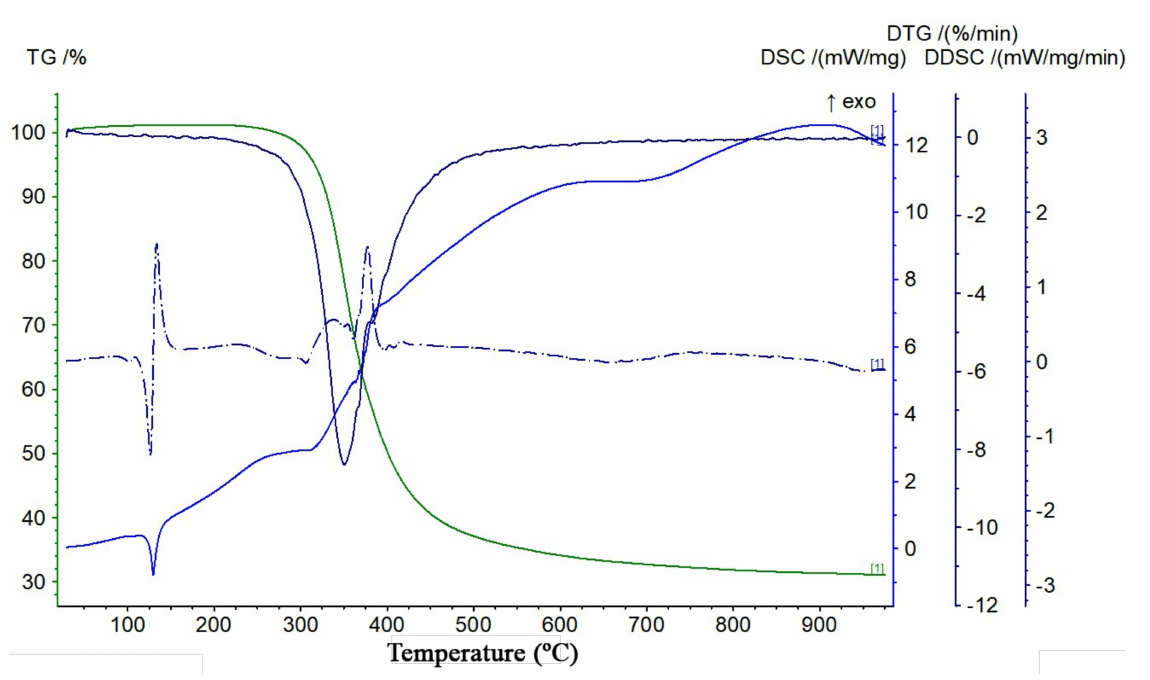
Figure 6. TG, DTG, DSC, and DDSC curves were obtained for the piperine crystal sample. As shown in Figure 7A, the decomposition of piperine occurs in one step, with a mass loss of approximately 64%. The initial temperature corresponding to the principal mass loss is 225 ◦ C, and the final decomposition temperature reached is 525 ◦ C.